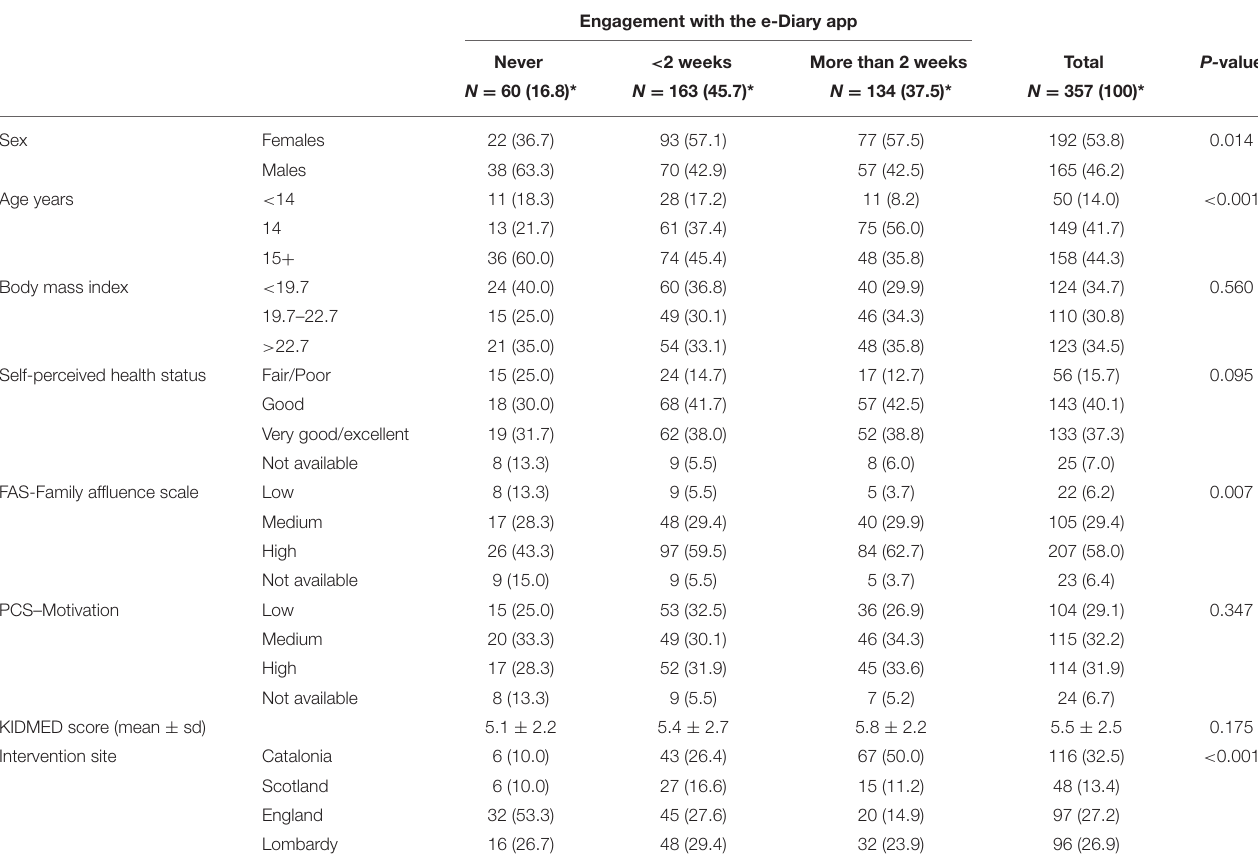
TABLE 3 | Engagement with the e-Diary app based on baseline participants characteristics ( N = 357).